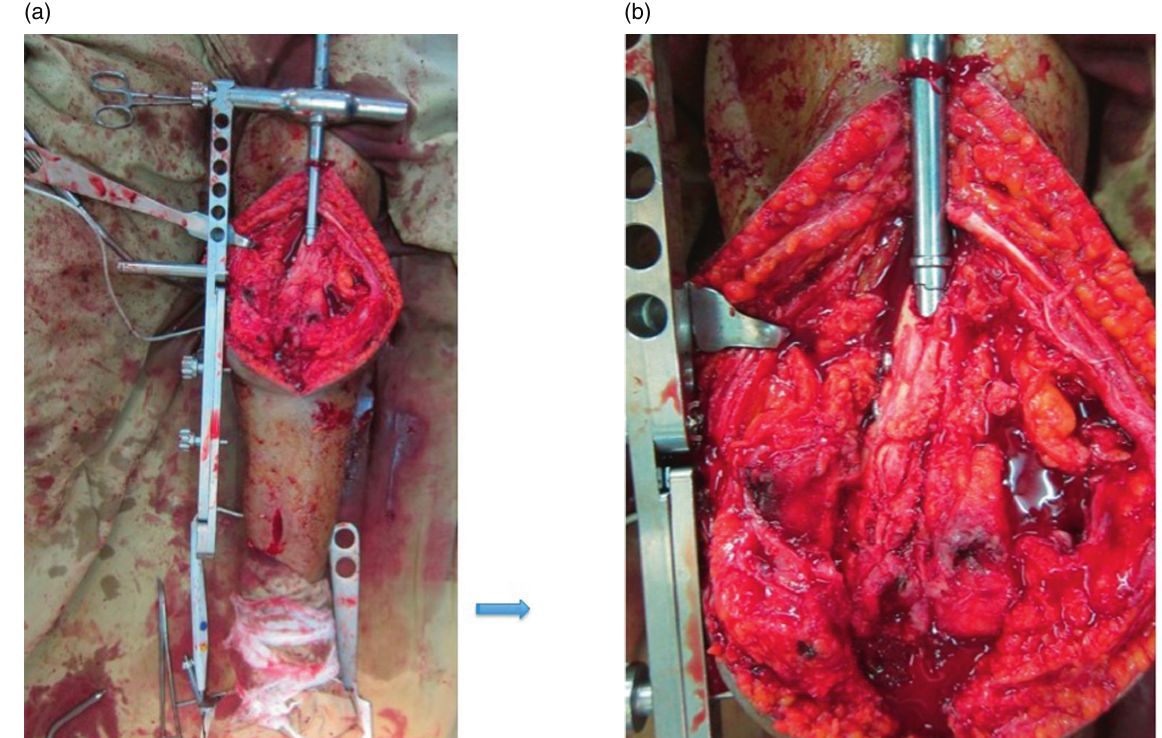
Figure 3. Intraoperative photograph of medial peripatellar exposure and nail entry point in anteromedial femur 10–14 cm above knee (a). Note the expanded cortical window (b) to permit entry of the nail without creating stress riser could cause a fracture when inserting the proximal bend of the ‘‘tibial’’ SIGN nail.